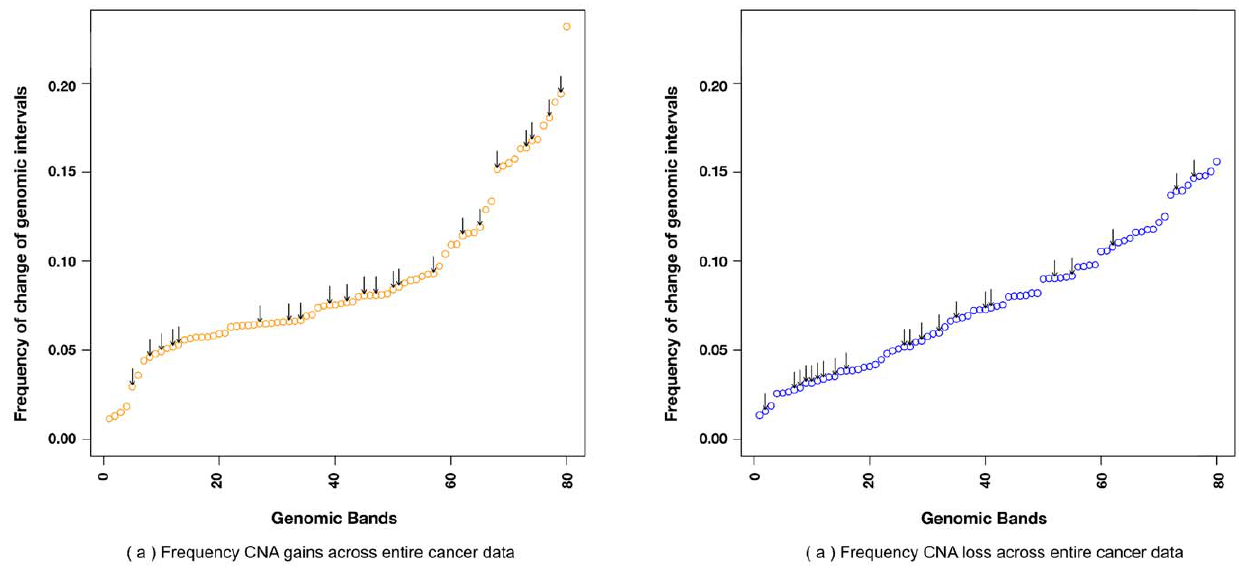
Figure 4. Not only CNA ‘‘hotspots’’ are informative in cancer classification. Genomic regions (bands) are sorted according to their overall frequency of CNAs observed. Those regions that are informative with respect to cancer type clustering are marked with arrows. a) Considering